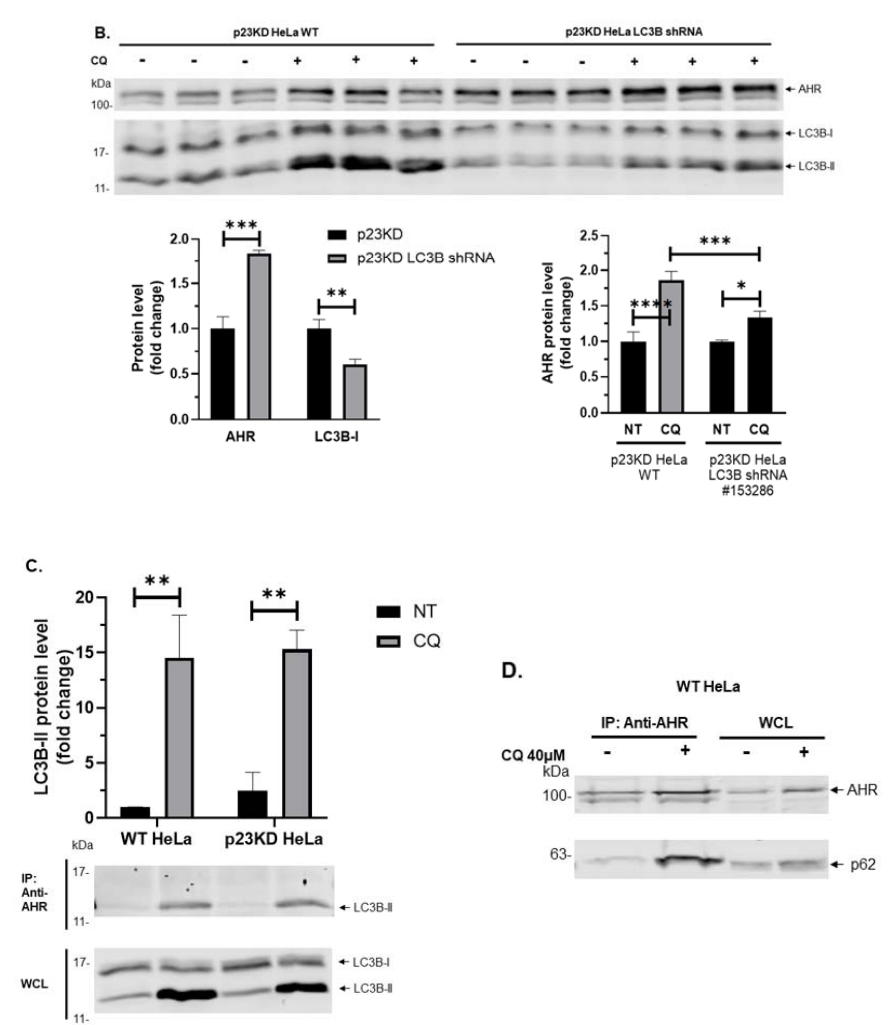
Figure 4. AHR interacts with LC3B-II and p62 in p23 stable knockdown (p23KD) and wild type (WT) HeLa cells. ( A ) Stable knockdown of LC3B in HeLa cells increased AHR protein levels and reduced the extent of the CQ-mediated increase of AHR. The images above show LC3B-I, LC3B-II, and AHR protein levels in WT and LC3B stable knockdown (KD) HeLa cells with or without treatment of 40 µ M CQ for 6 h of triplicate samples. The graphs represent replicate data of means ± SD of one experiment, n = 3. WT (left graph) and NT (right graph) were arbitrarily set as 1 for data normalization. This experiment was repeated once with similar results. Data of the left graph were analyzed by multiple t -tests corrected with the Holm-Sidak method for multiple comparisons to determine statistical significance whereas data of the right graph were analyzed by one-way ANOVA with Sidak’s multiple comparisons test to determine statistical significance. ( B ) Transient knockdown of LC3B in p23 stable knockdown (p23KD) HeLa cells showed a higher increase of AHR protein levels when compared to that in WT HeLa cells (see A) and reduced the extent of CQ-mediated increase of AHR. The graphs represent replicate data of means ± SD of one experiment, n = 3. p23KD (left graph), and no addition as no treatment (NT, right graph) were arbitrarily set as 1 for data normalization. This experiment was repeated once with similar results. Data of the left graph were analyzed by multiple t -tests corrected with the Holm-Sidak method for multiple comparisons to determine statistical significance whereas data of the right graph were analyzed by one-way ANOVA with Sidak’s multiple comparisons test to determine statistical significance. ( C ) LC3B-II was co-immunoprecipitated by AHR polyclonal antibody SA210 in both cell lines after treatment of 40 µ M CQ for 6 h. Data were presented from three independent experiments as means ± SD, n = 3. WT HeLa NT group was arbitrarily set as one for comparison (no error bar). Data were analyzed by multiple t -tests corrected with the Holm-Sidak method for multiple comparisons to determine statistical significance. The images below are representative of the replicate